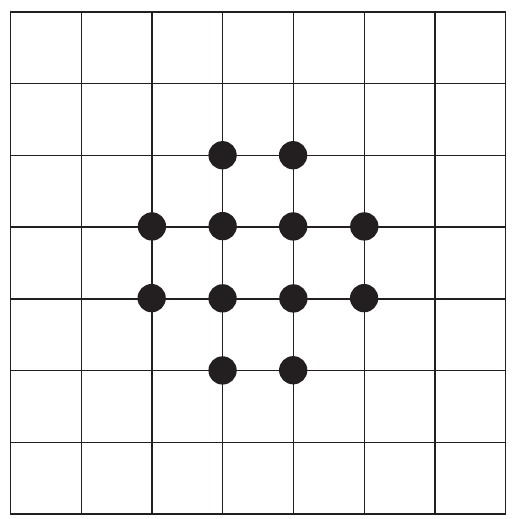
Figure 1: Position of 12, 5m × 30 cm plots, placed 10m apart within a 70 m × 70m grid used to sample snowshoe hare